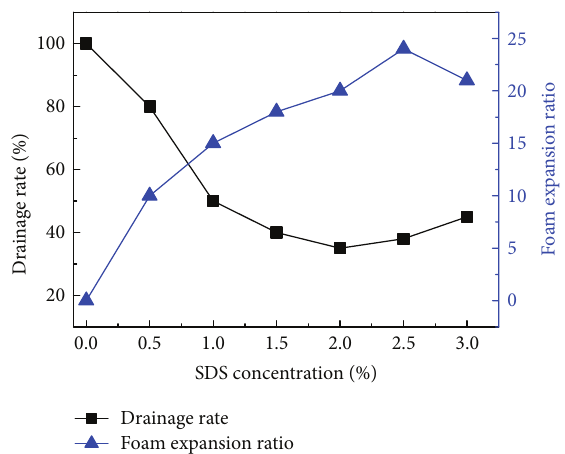
Figure 5: Change trends of drainage rate and foam expansion ratio with different